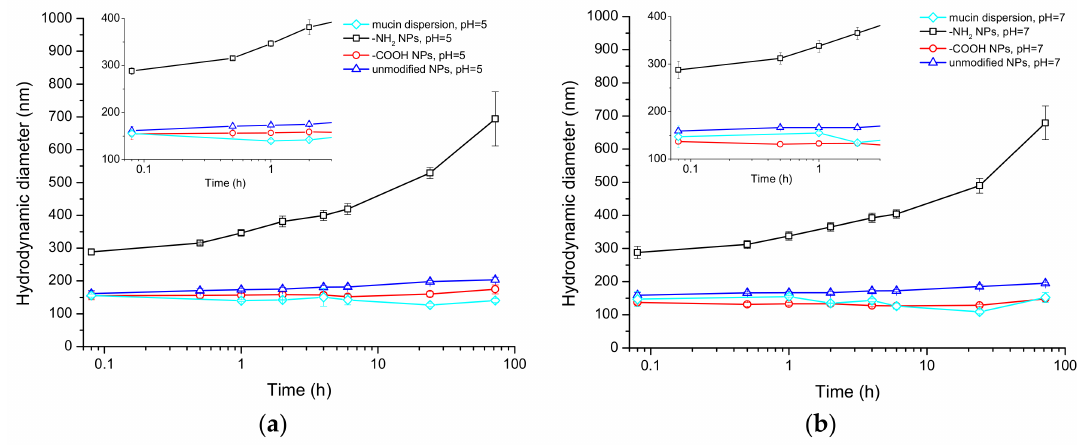
Figure 1. Hydrodynamic size of polystyrene NPs over time in mucin dispersion at ( a ) pH 5 and ( b ) pH 7 measured by Dynamic Light Scattering